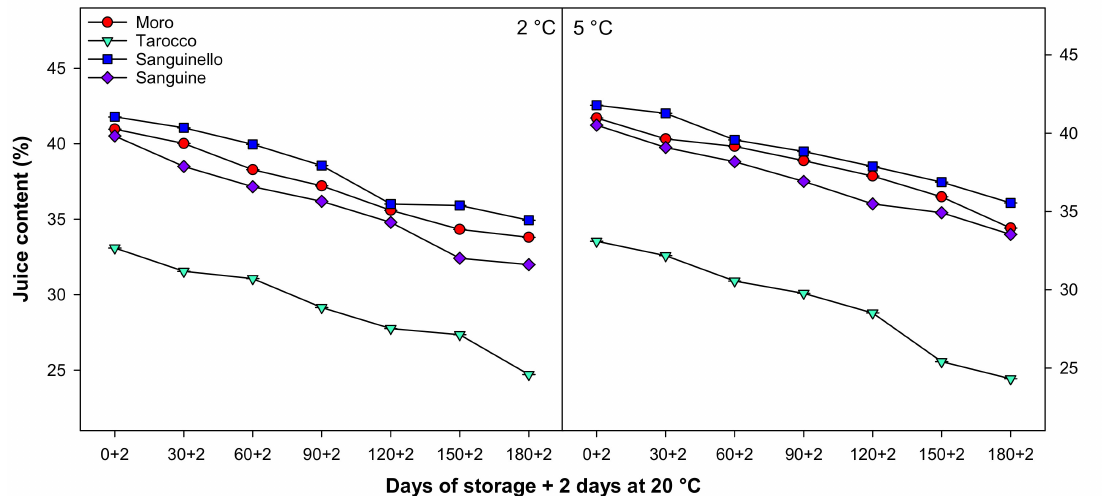
Figure 4. Changes in juice content of blood orange cultivars (‘Moro’, ‘Tarocco’, ‘Sanguinello’, and ‘Sanguine’) during cold storage at 2 and 5 ◦ C and 90% relative humidity (RH) plus 2 days at 20 ◦ C. Vertical bars represent ± standard error (SE) of means. LSD ( p < 0.05) value is 1.13.